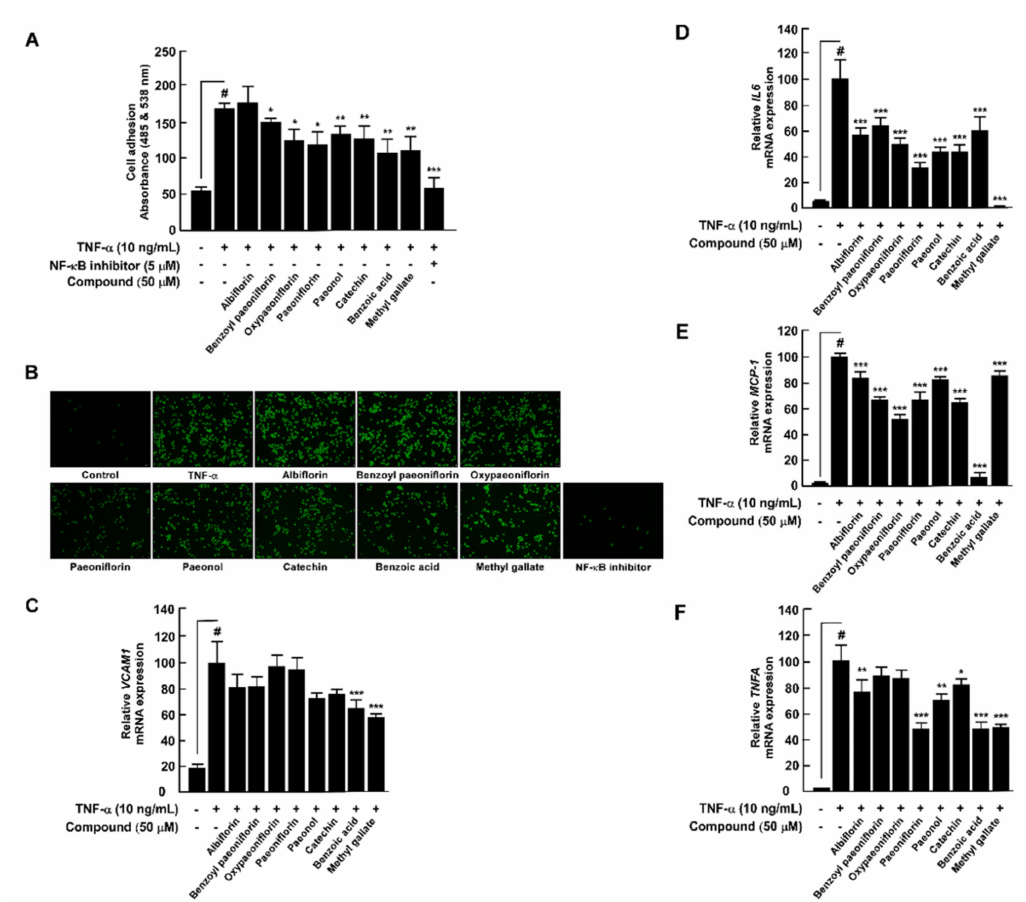
Figure 4. Paeonia lactiflora extract (PLE) compounds inhibit TNF- α -induced monocyte adhesion capacity and proinflam- matory cytokines in HUVECs. ( A ) THP-1 cell adhesion to HUVECs after treatment with PLE components and TNF- α . Parthenolide (5 µ M), an effective NF-kB inhibitor, was used as a positive control. ( B ) THP-1 cell adhesion to HUVECs was assessed using a fluorescence microscope. The relative mRNA levels of VCAM1 ( C ), IL6 ( D ), CCL2 ( E ), and TNFA ( F ) were measured using qRT-PCR. # p < 0.05, compared with the control group; * p < 0.05, ** p < 0.01, and *** p < 0.001, compared with the group exposed to TNF- α alone. Data are presented as the mean ± standard deviation of three independent